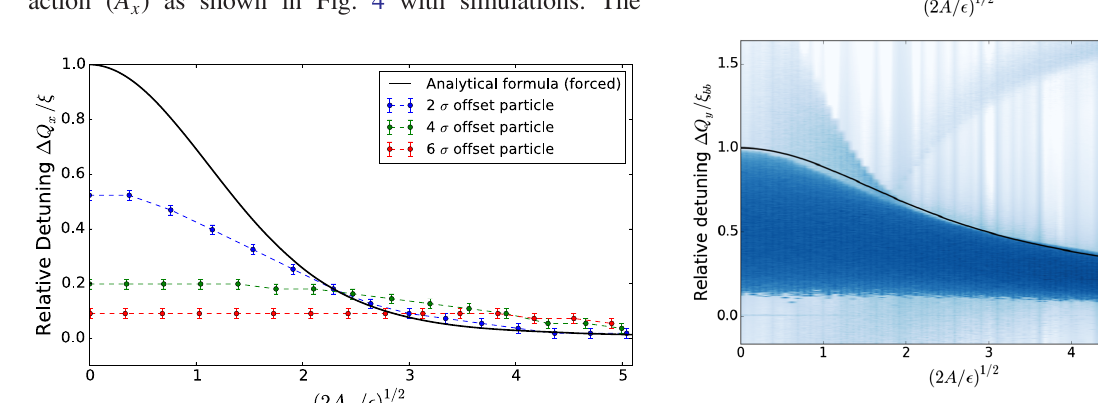
FIG. 4. Simulated relative amplitude detuning versus forced oscillation amplitude for particles with increasing free oscillation amplitudes: 2 σ , 4 σ and 6 σ . Equation (18) is also shown representing the 0 σ particle.